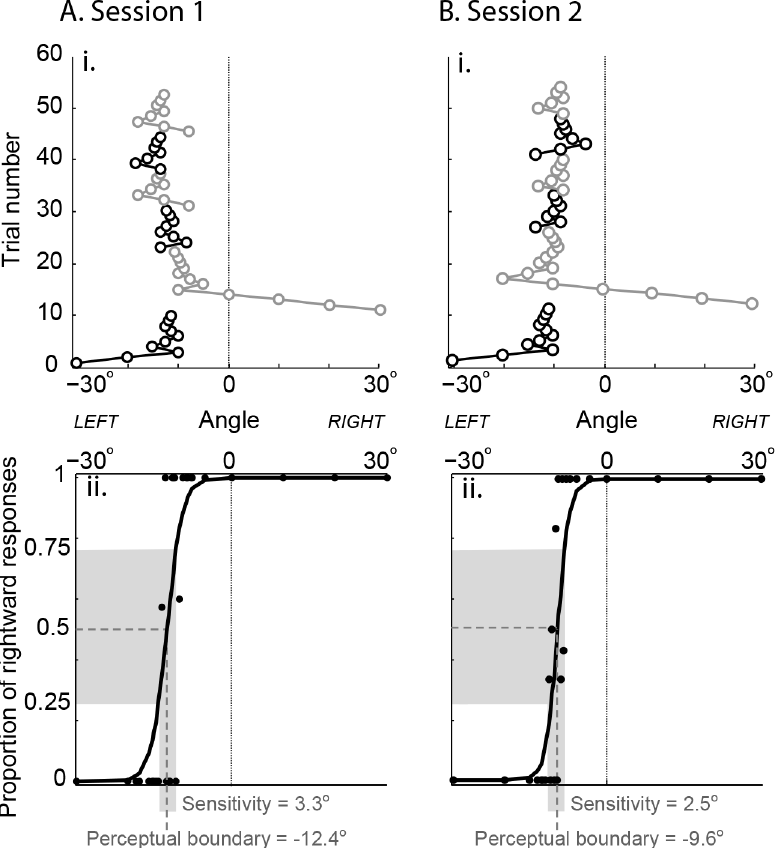
Fig 3. Adaptive staircase performance of an older subject (age 56) in two sessions conducted 7 days apart. A. i. Subject performance on 6 staircases in session 1: trial number vs. angle of the white line relative to true index finger angle (0°). Black: staircases that began with a leftward trial. Grey: staircases that began with a rightward trial. ii. Proportion of rightward responses at each tested angle (black circles) with fitted function. Perceptual boundary (proprioceptive bias) was -12.4°, proprioceptive sensitivity (width of grey shaded area on x-axis) was 3.3°. B. i. Subject performance 7 days later on 6 staircases. ii. Both perceptual boundary and sensitivity (-9.6° and 2.5°, respectively) appear similar to the first session.